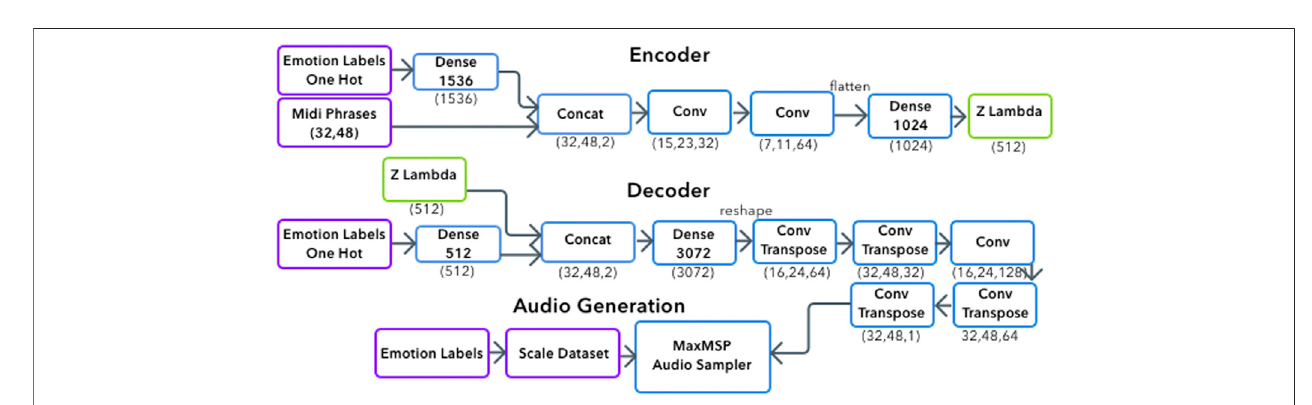
FIGURE 1 | Rose plots of dataset validation and generation evaluation.